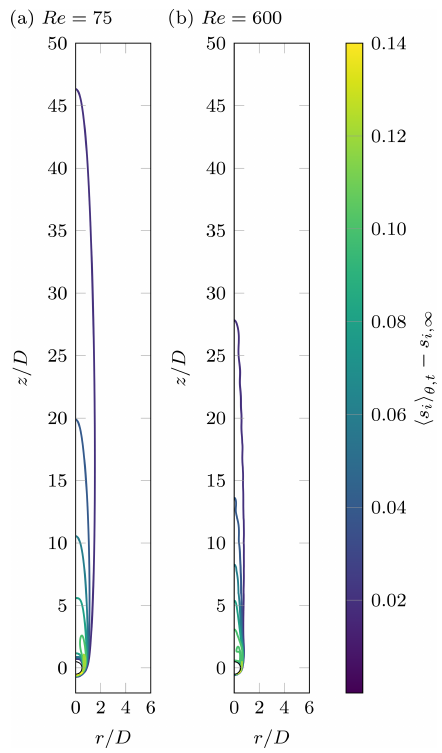
Figure 5. Contours of excess supersaturation in the wake, averaged over time and azimuthal direction at T ∞ = − 15 ◦ C. (a) Axisym- metric regime at Re = 75. (b) Chaotic regime at Re =